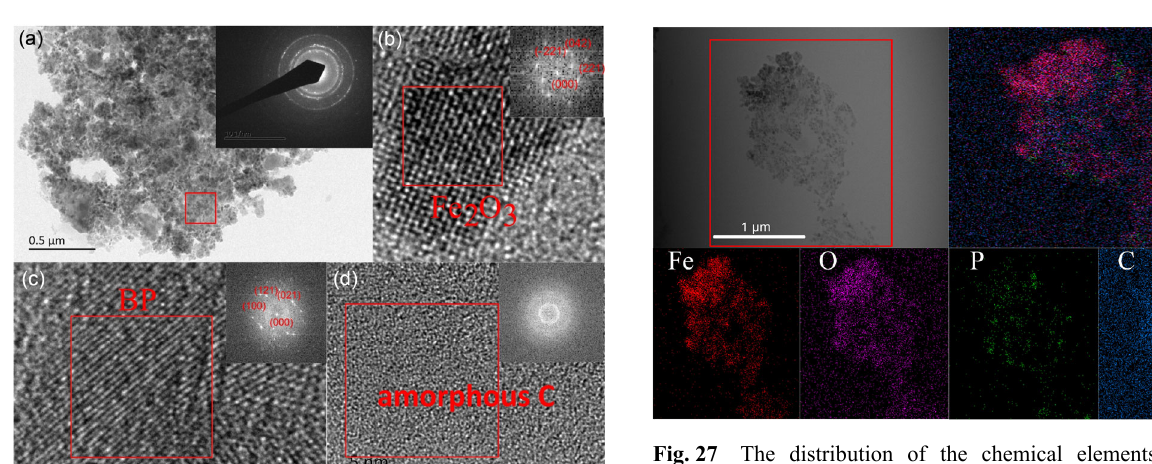
Fig. 27 The distribution of the chemical elements in wear debris.